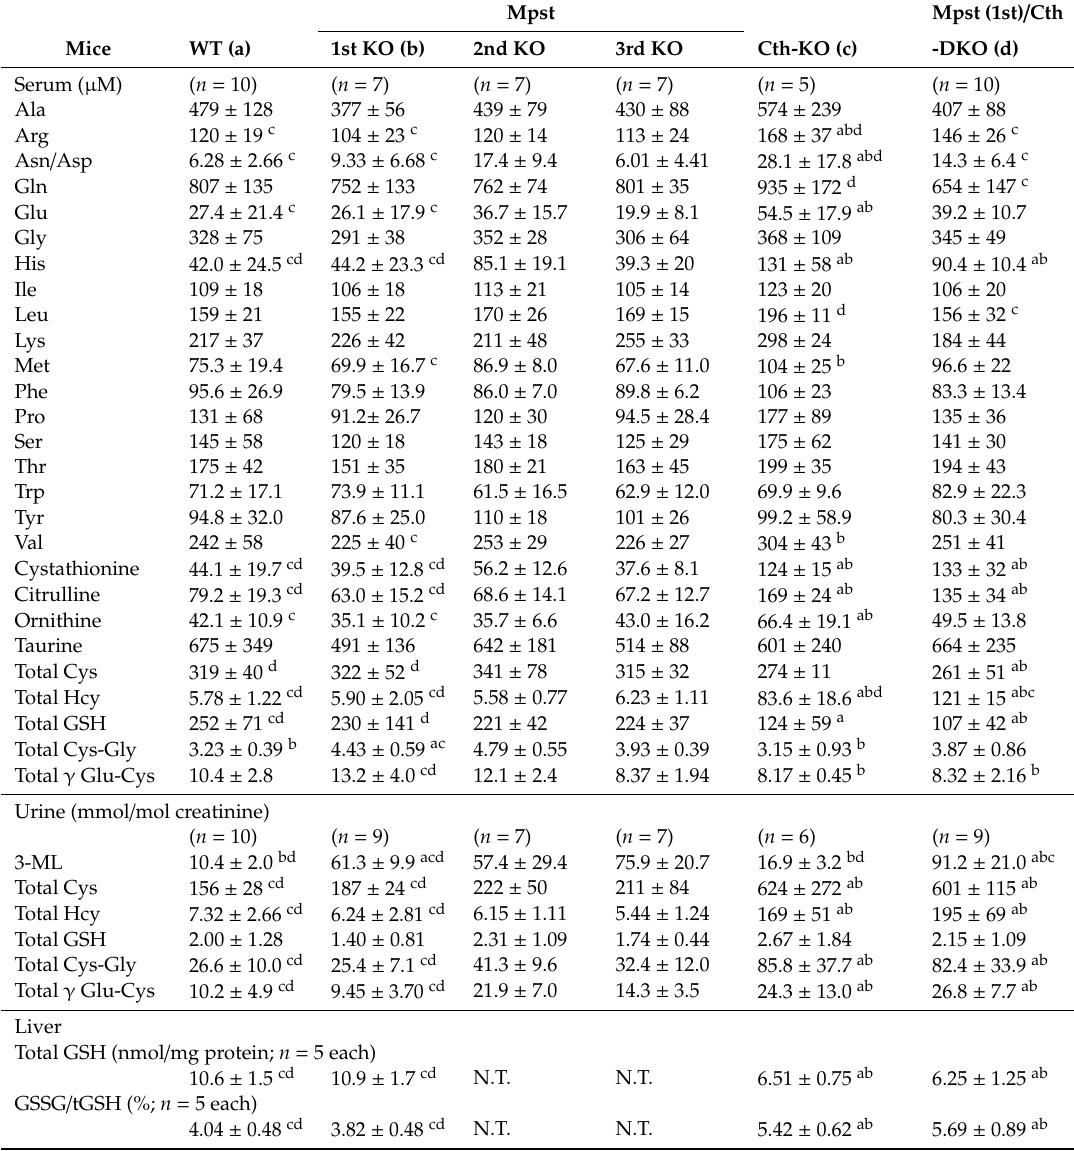
Table 2. Concentrations of serum amino acid / thiol compounds, urinary thiol compounds, and liver glutathione in adult wild-type, Mpst (1st–3rd)-KO, Cth-KO, and Mpst (1st) / Cth-DKO